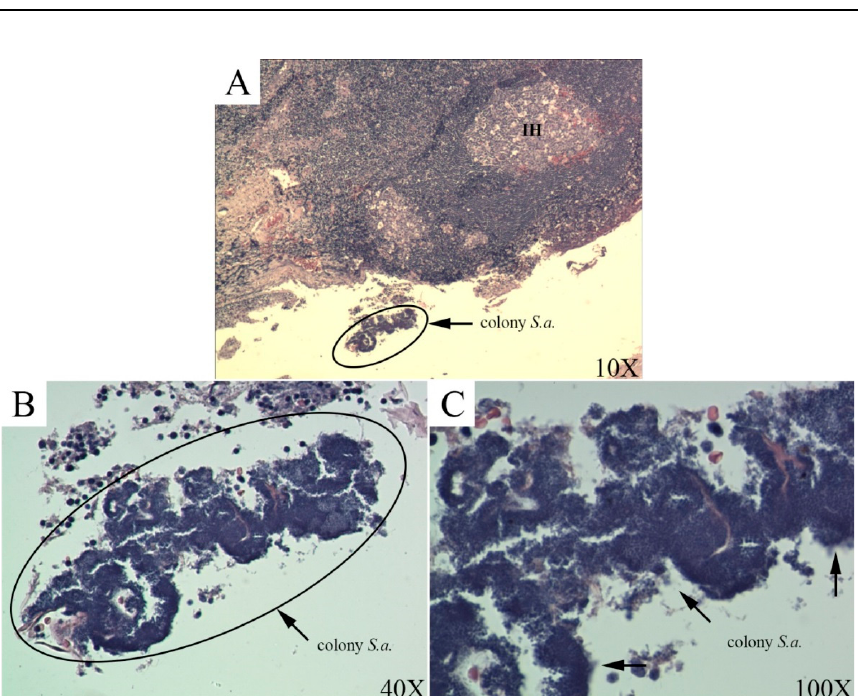
Figure 3. Histological examination (hematoxylin—eosin staining) of palatine tonsil tissue: ( A ) in- Histological examination (hematoxylin—eosin staining) of palatine tonsil terfollicular hyperplasia, as a consequence of the inflammatory process; colony of S. aureus ; ( B,C ) colony of S. aureus .